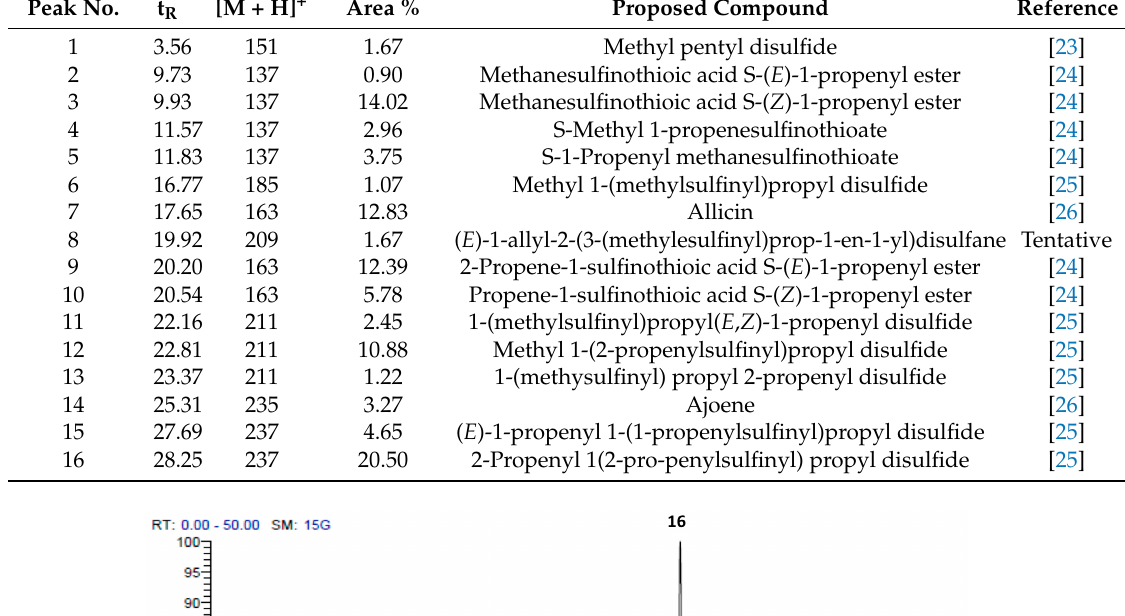
Table 1. Identification of secondary metabolites in Allium ursinum extract by LC-ESI-MS/MS. Peak No.